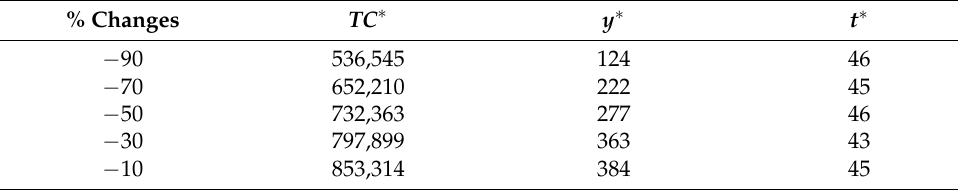
Table 3. Sensitivity analysis of the setup cost ( K